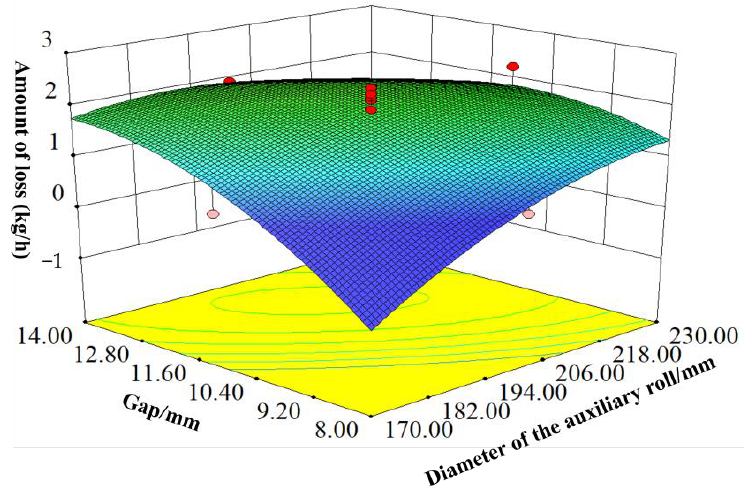
Figure 12. Influence of the gap and assist roller diameter on the amount of loss.